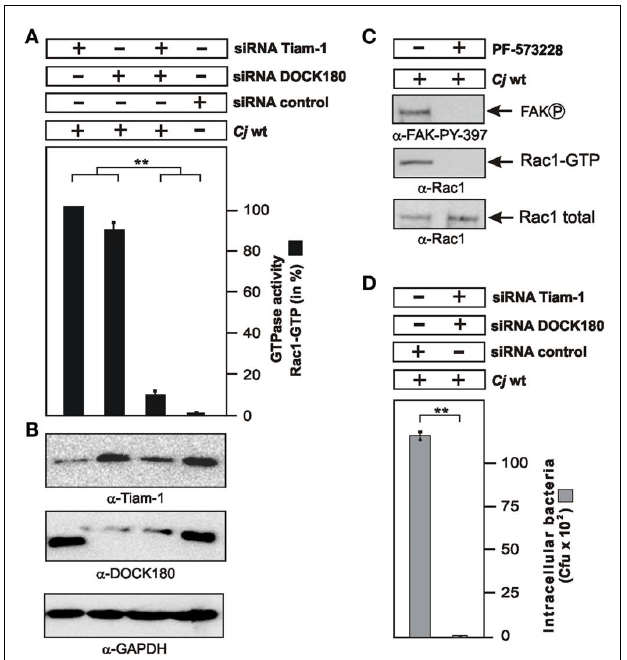
FIGURE 6 | Importance ofTiam-1, DOCK180, and FAK activation on C. jejuni -induced Rac1 activation and bacterial invasion. (A) INT-407 cells were transfected for 48h with siRNA forTiam-1, DOCK180, or a scrambled siRNA as control. Quantification of Rac1 GTPase activity after infection with WT C. jejuni 81–176 for 6h.The presence of bound, active Rac1-GTP or was analyzed by G-LISA. One hundred percentage of activity corresponds to the highest amount of detected GTPase-GTP level (lane 1). (B) Immunoblotting with the indicated antibodies confirmed knockdown of the proteins. GAPDH expression levels were determined as control. (C) Addition of FAK kinase inhibitor PF-573228 during a 6h infection led to the disappearance of Rac1-GTP and FAK phosphorylated atY-397. (D) Intracellular bacteria were quantified by gentamicin protection assays in the indicated siRNA-treated cells. ∗∗ p ≤ 0.001 were considered as statistically significant as compared to the